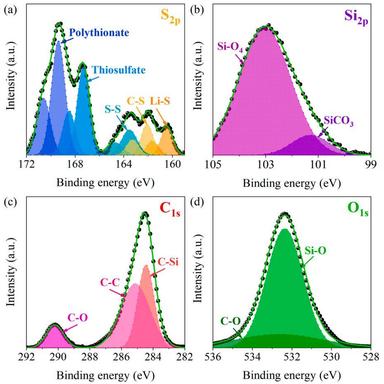
High-resolution XPS spectra of the spent S-SiOC electrode, displaying the (a) S2p, (b) Si2p, (c) C1s, and (d) O1s peaks.